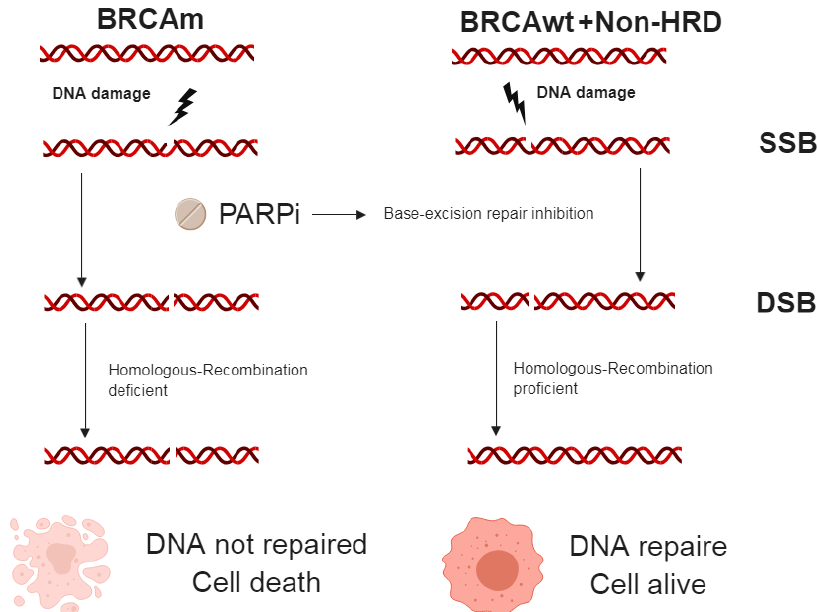
Figure 1. Synthetic lethality concept [119]. A DNA damage can lead to a single-strand break (SSB), and PARP enzymes play an essential role in SSB repair. The administration of PARPi will inhibit base-excision repair for SSB. If SSB are not repaired, continuous damage can progress to double-strand breaks (DSB). DSBs are usually repaired through the BRCA dependent homologous-recombination process. However, in cells with BRCA m the homologous-recombination pathway for DSB repair is damaged and leads to cell death. BRCA m: BRCA mutation, BRCA wt: BRCA wildtype, Non-HRD: No homologous recombination deficiency, SSB: single strand break, DSB: double strand break.